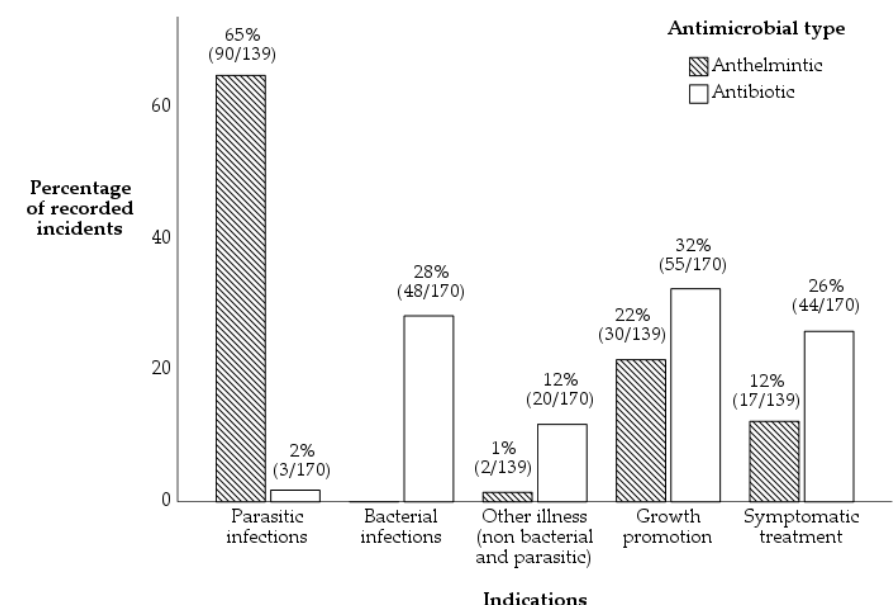
Figure 2. Association between 309 incidents where antimicrobials were used (anthelmintics n = 139, antibiotics n = 170) and indication of use on 276 enterprises located in the Central and Western division of Viti Levu, Fiji. (Chi-square statistics X 2 = 162, p < 0.001).